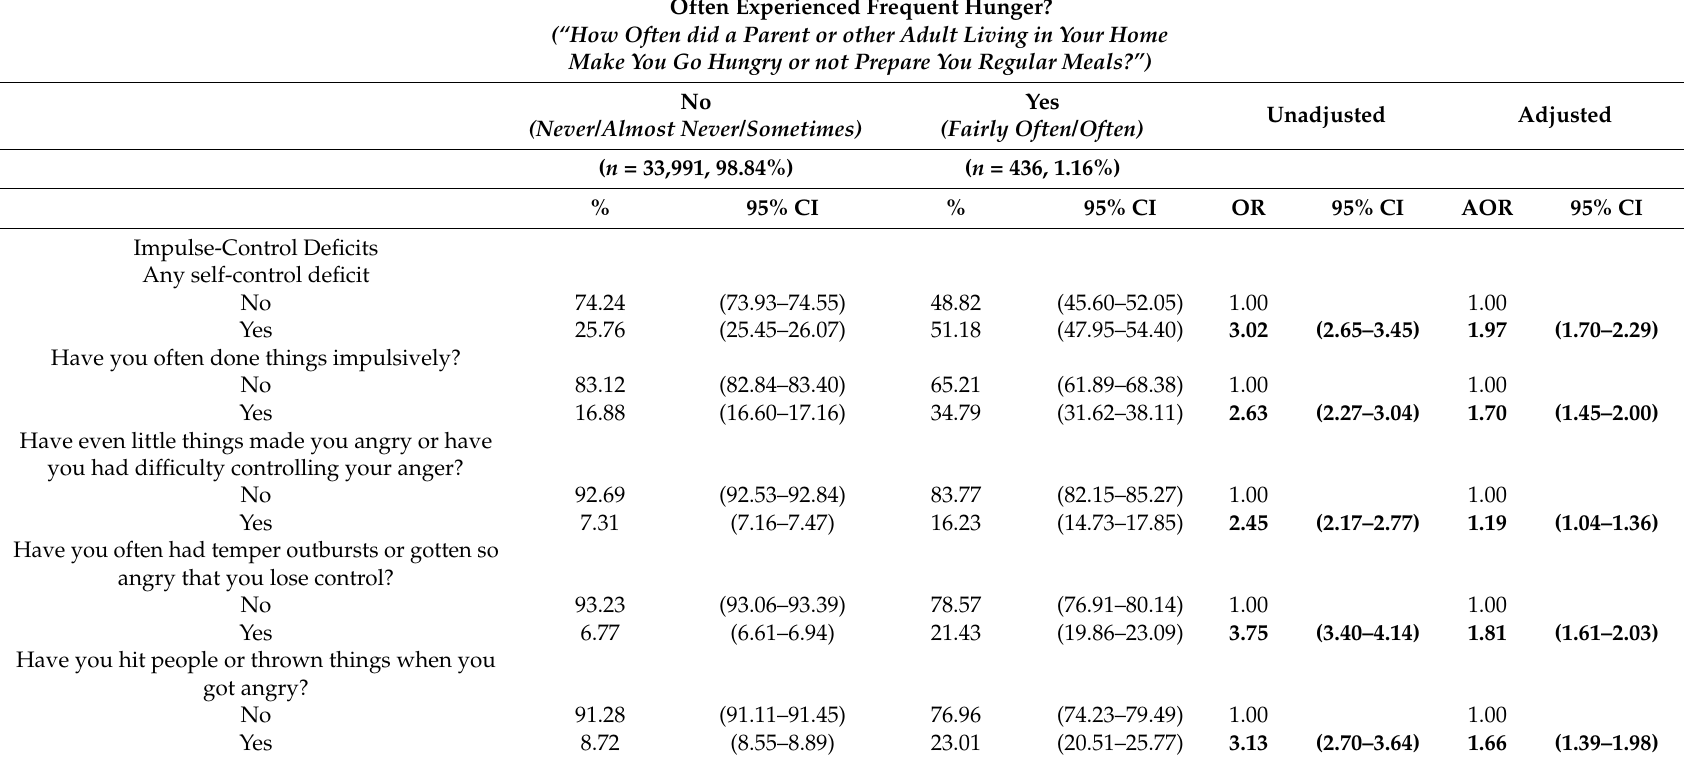
Table 4. Impulse-control problems among individuals who often experienced hunger during childhood in the United